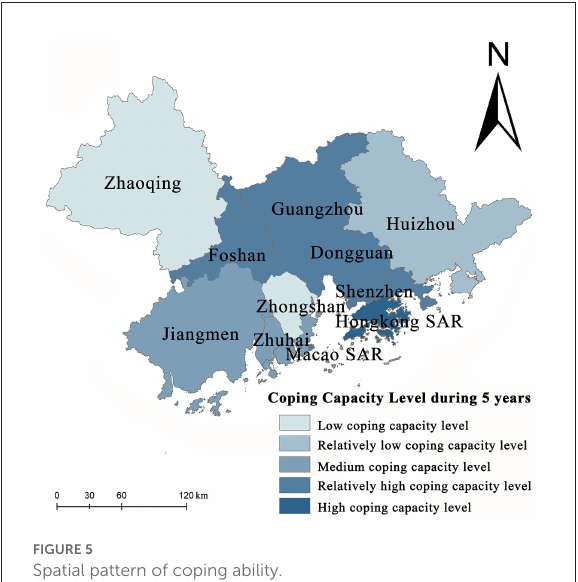
FIGURE4 Coping ability in 2015-2019a.